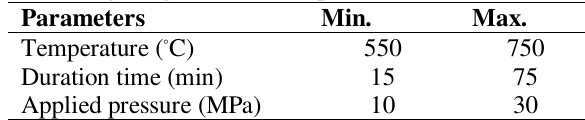
Working ranges of selected parameters.